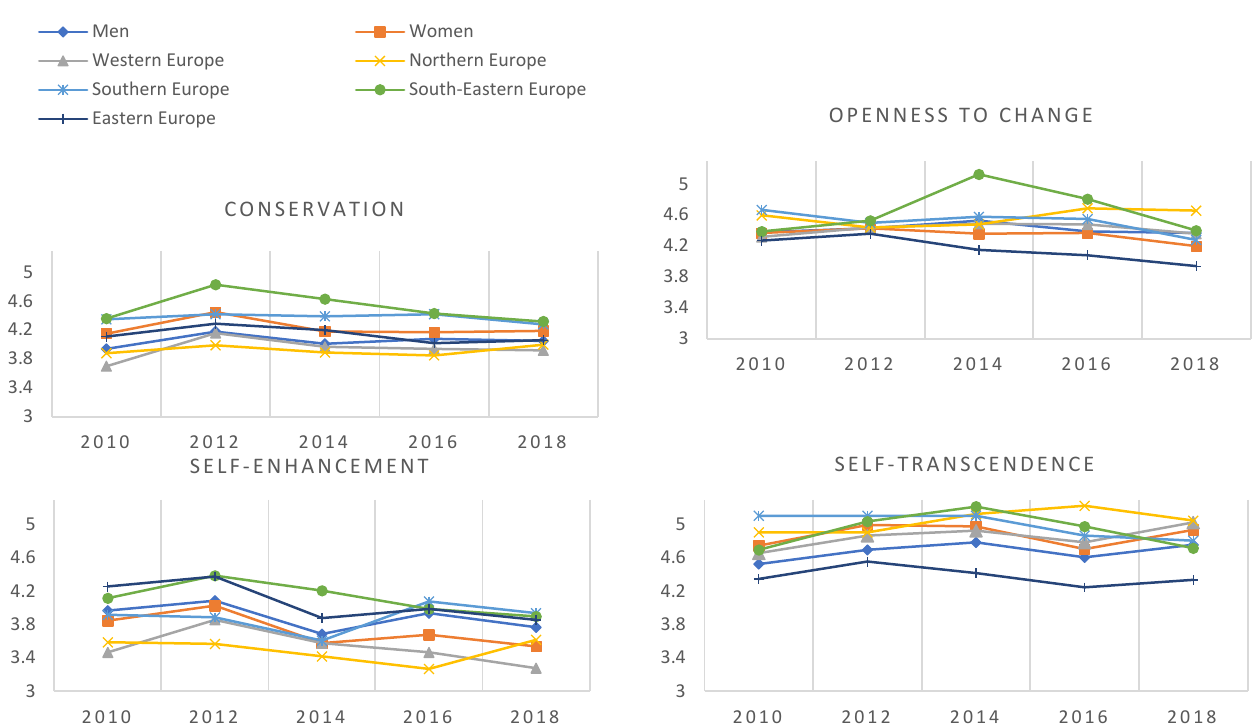
Figure 2. Higher-order values (scale 1–6) by gender and European region among NEETs from 2010 to Figure 2. Higher ‐ order values (scale 1–6) by gender and European region among NEETs from 2010 2020 (ESS rounds to 2020 (ESS rounds 5–10).